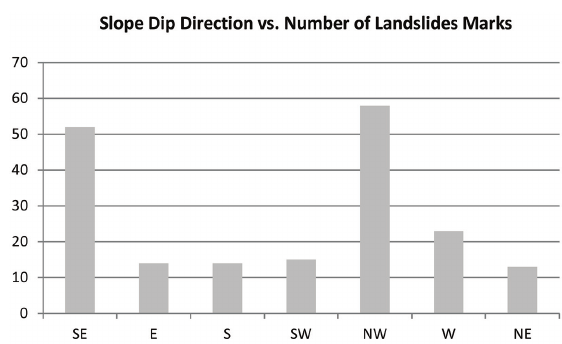
Figure 6 - Graph showing the relation between quantity of landslides locations and slope inclination